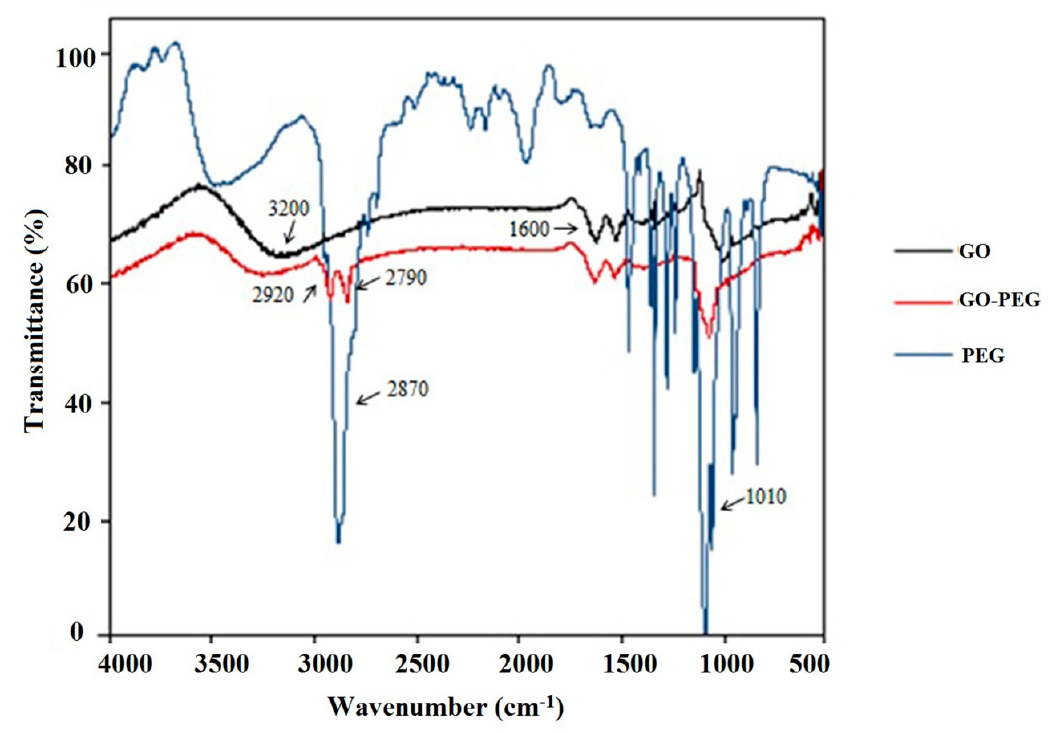
Figure 2. FT-IR spectrum of GO, GO/PEG-20000 and PEG-20000.